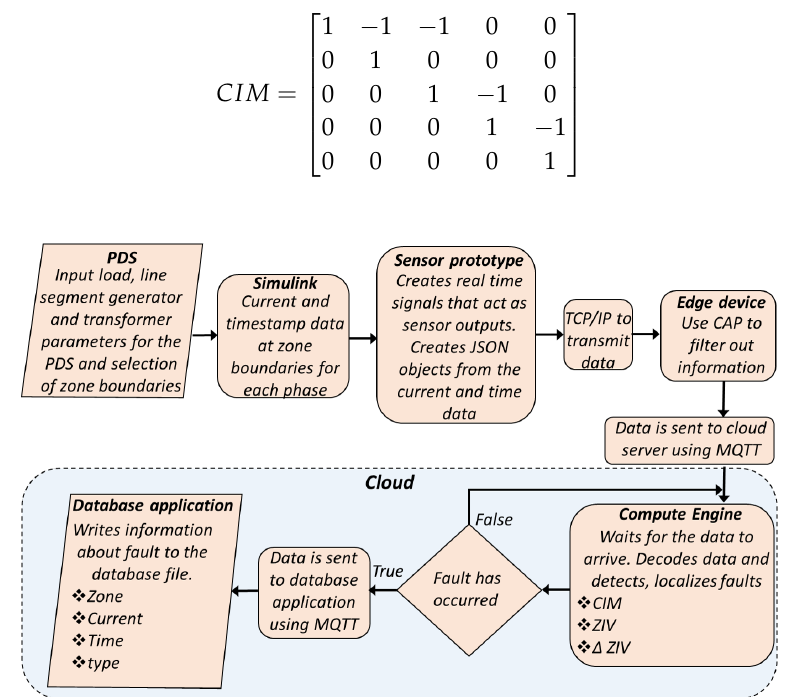
Figure 2. Flowchart of our proposed